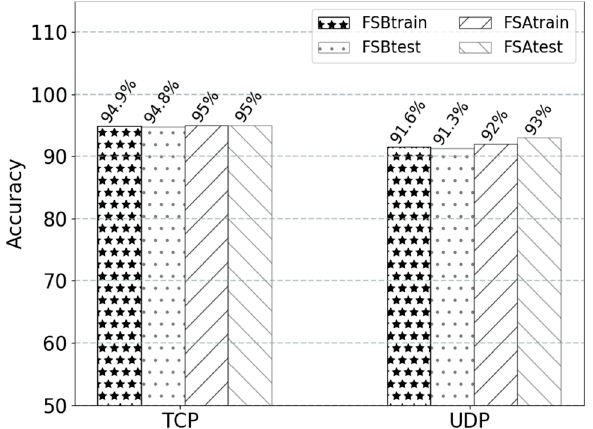
Figure 10. FSBtrain represents the training accuracy before feature selection, and FSBtest represents the test accuracy before feature selection. FSAtrain indicates the training accuracy rate after feature selection, and FSAtest indicates the test accuracy rate after feature selection.